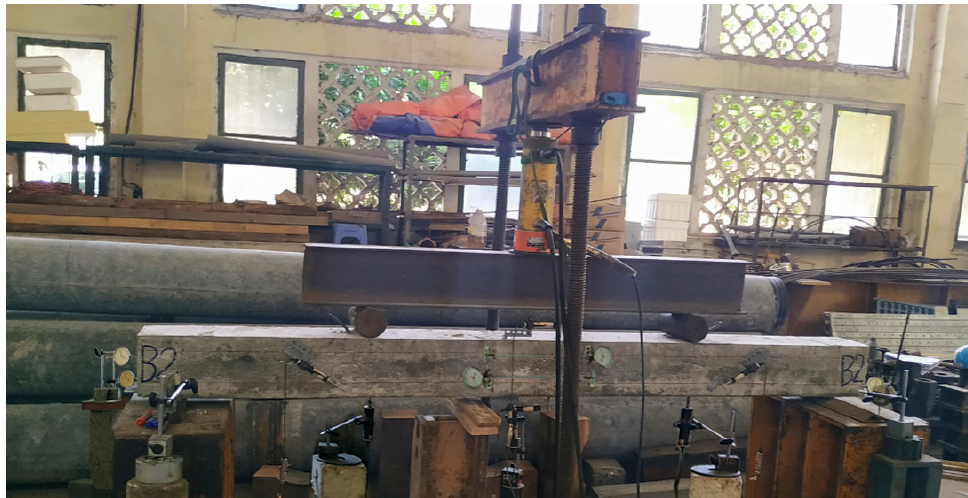
Figure 9. The scheme of the layout instruments for bending